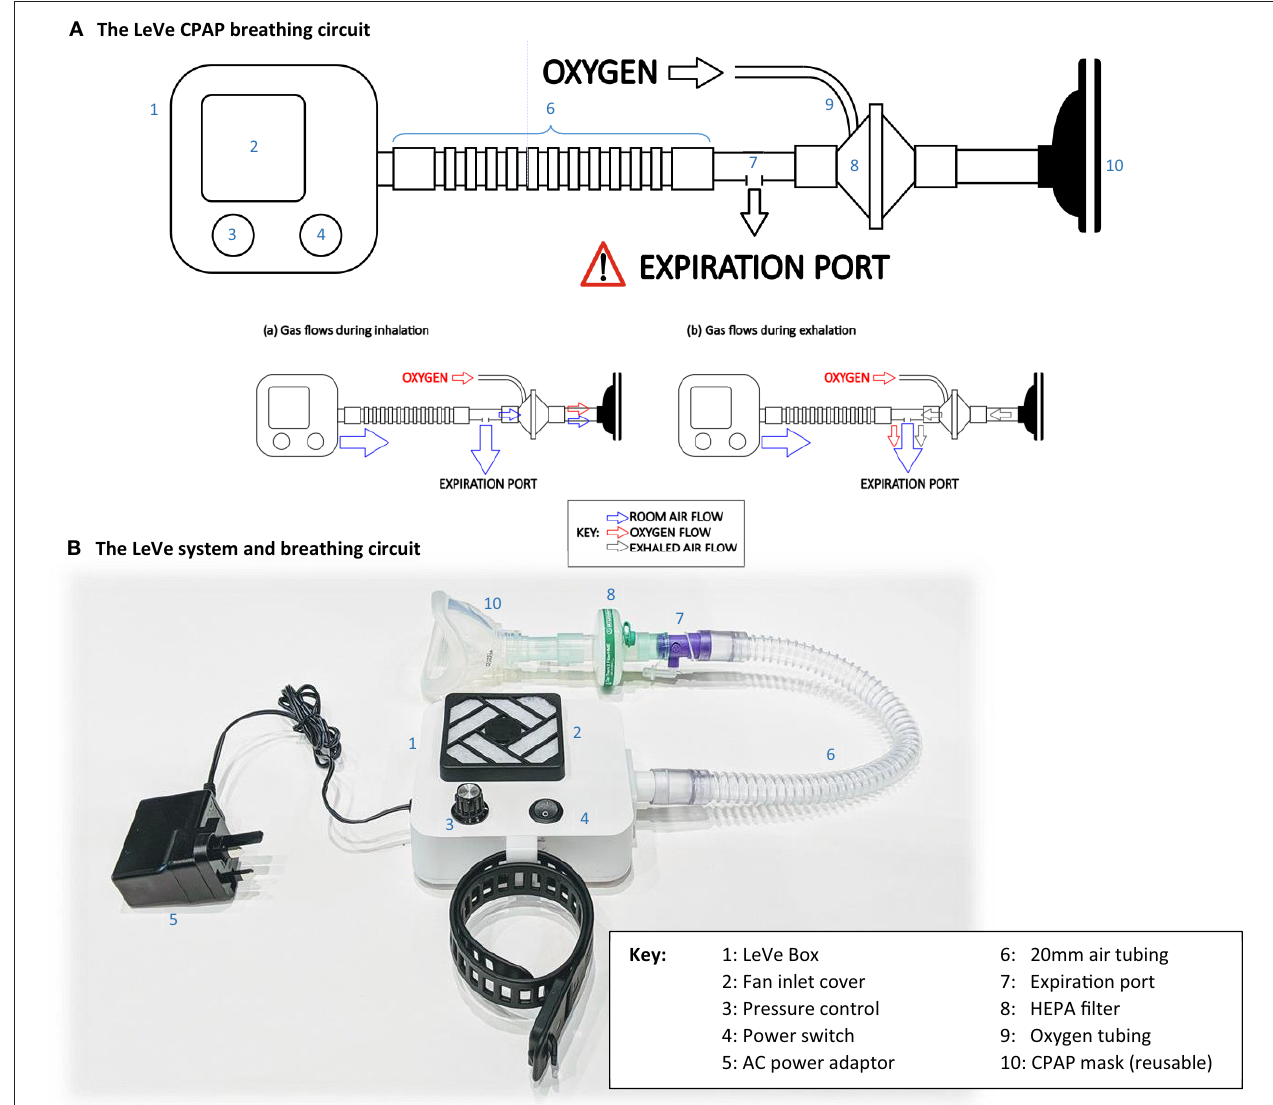
FIGURE 4 | (A) The LeVe CPAP breathing circuit and (B) The complete LeVe